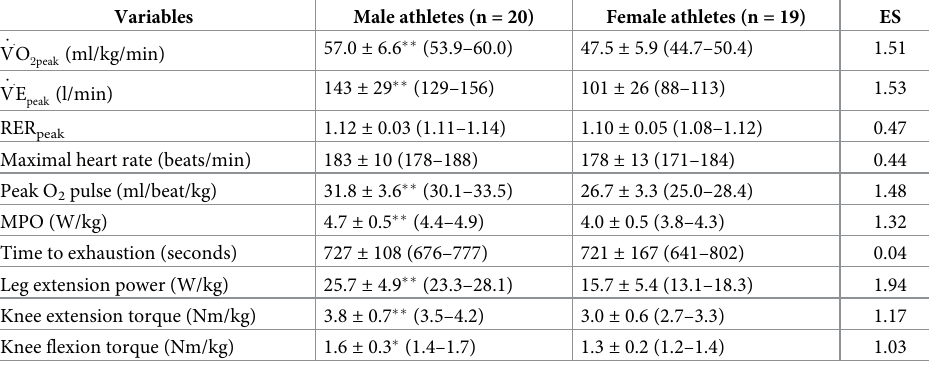
Table 2. Physiological and performance characteristics of athletes.